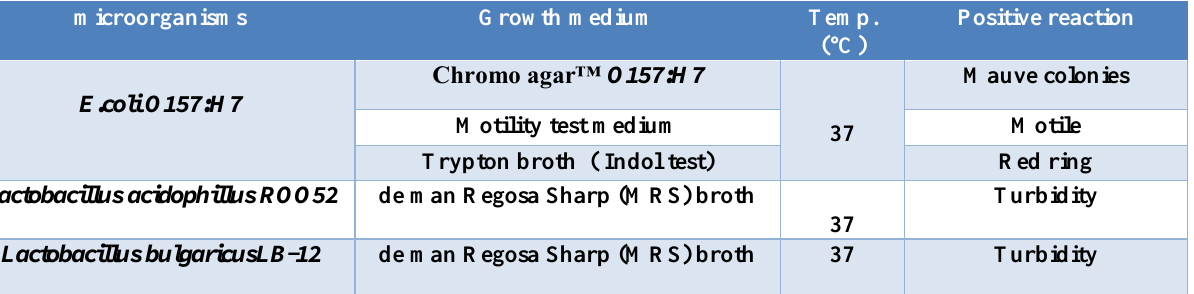
Table, 1: Cultural characteristics of E.coliO157:H7 and lactobacilli :